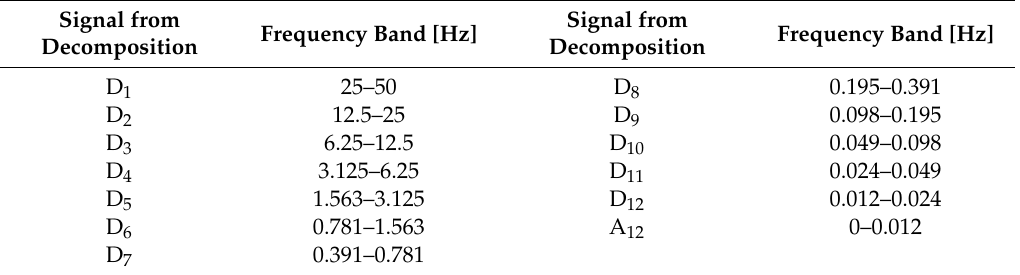
Table 1. Frequency bands of signals cDi and cAi for wavelet